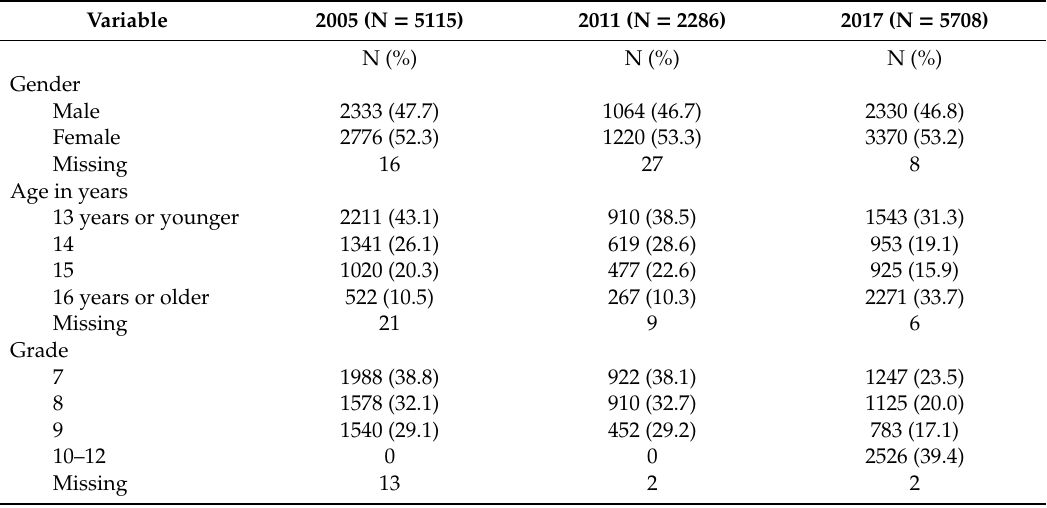
Table 2. Characteristics of participating students in the 2005, 2011 and 2017 surveys in Lebanon (N =